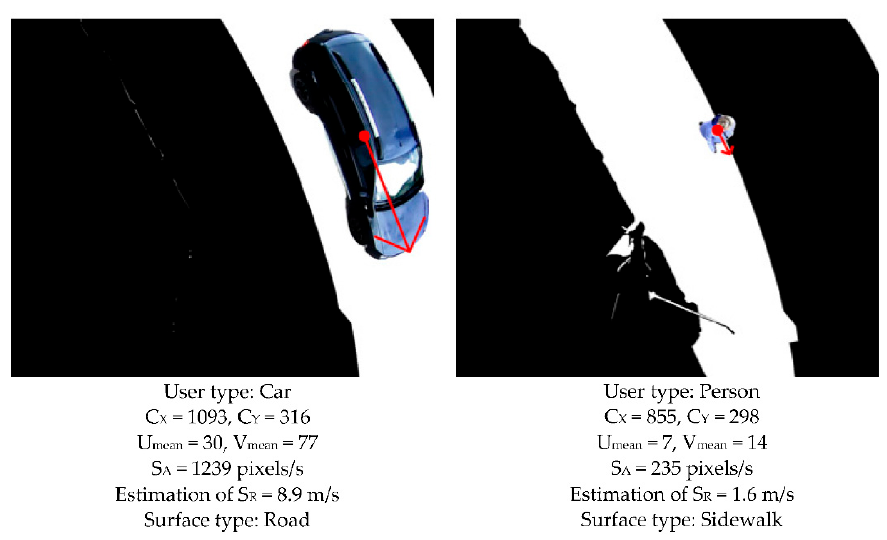
Figure 14. Detection, segmentation, and analysis of the movement of a car and a pedestrian. ( Top ): YOLOv4 detection. ( Center ): fusion of the three algorithms. ( Bottom ): quantified contextual information (type, positioning, and speed of the user, the nature of the surface).